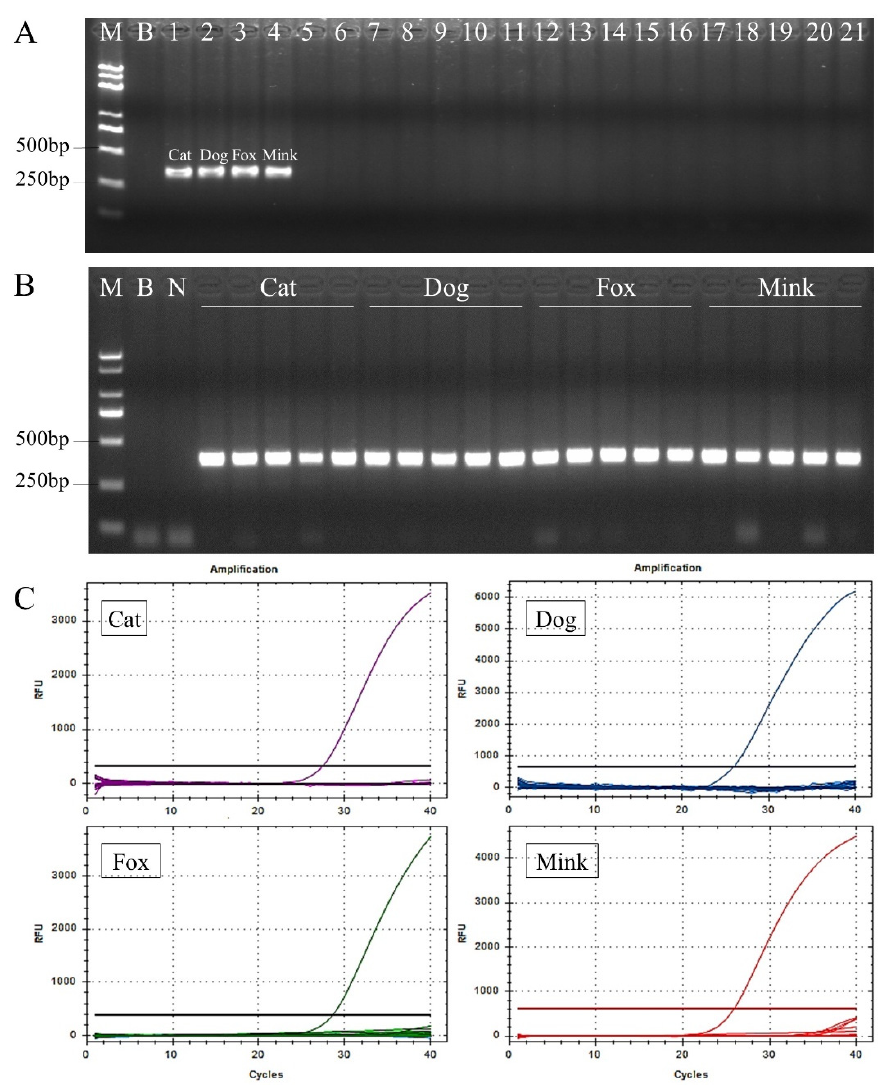
Figure 2. Evaluation of specificity and conservation of the nuclear DNA target sequences, primers, and probes for cat, dog, fox, and mink DNA. ( A ) Evaluation of specificity of the nuclear DNA target sequences and primers using conventional PCR. DNA templates of the conventional PCR are Lane B, blank (water); Lane N, negative control; Lane 1, cat; Lane 2, dog; Lane 3, fox; Lane 4, mink; Lane 5, domestic horse; Lane 6, donkey; Lane 7, yak; Lane 8, cattle; Lane 9, buffalo; Lane 10, sheep; Lane 11, goat; Lane 12, pig; Lane 13, deer; Lane 14, rabbit; Lane 15, mouse; Lane 16, rat; Lane 17, hamster; Lane 18, guinea pig; Lane 19, chicken; Lane 20, duck; Lane 21, goose. ( B ) Evaluation of conservation of the nuclear DNA target sequences and primers in five individual samples from each species. ( C ) Evaluation of specificity of each probe for cats, dogs, foxes, and minks using TaqMan real-time PCR.